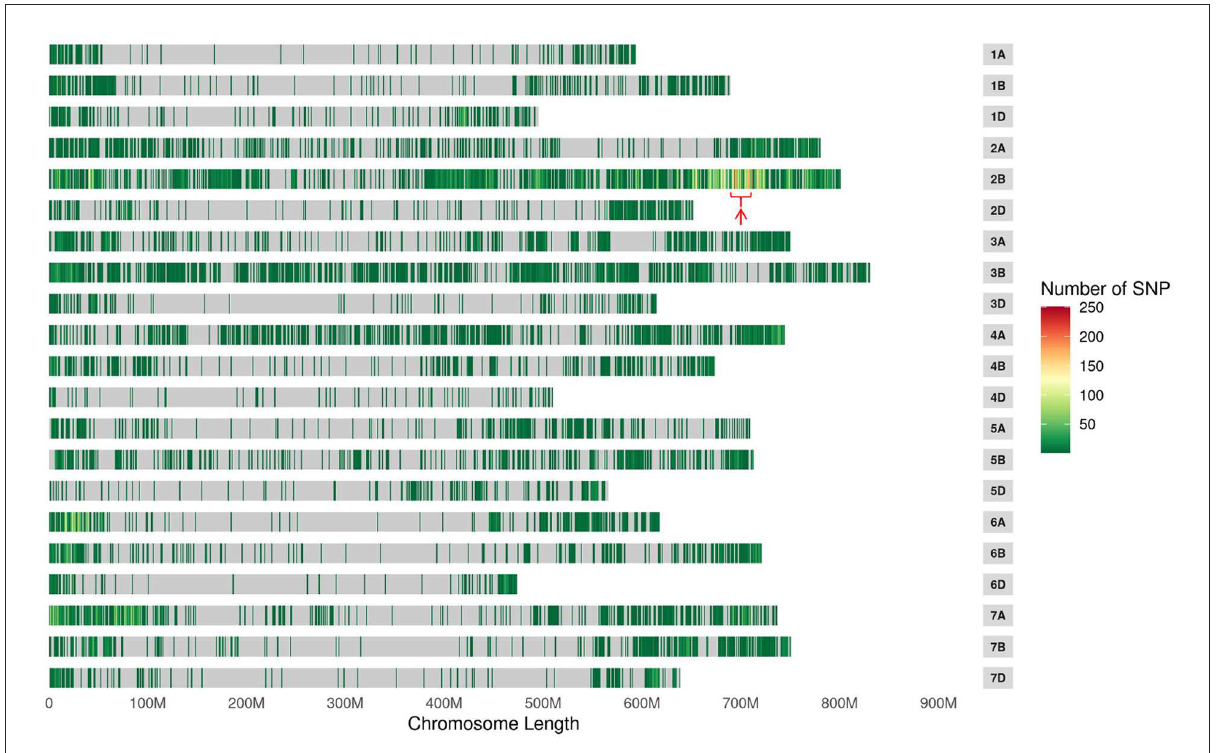
FIGURE1 The distribution of single nucleotide polymorphisms (SNPs) and significant candidate intervals (indicated with red arrow) across the 21 wheat